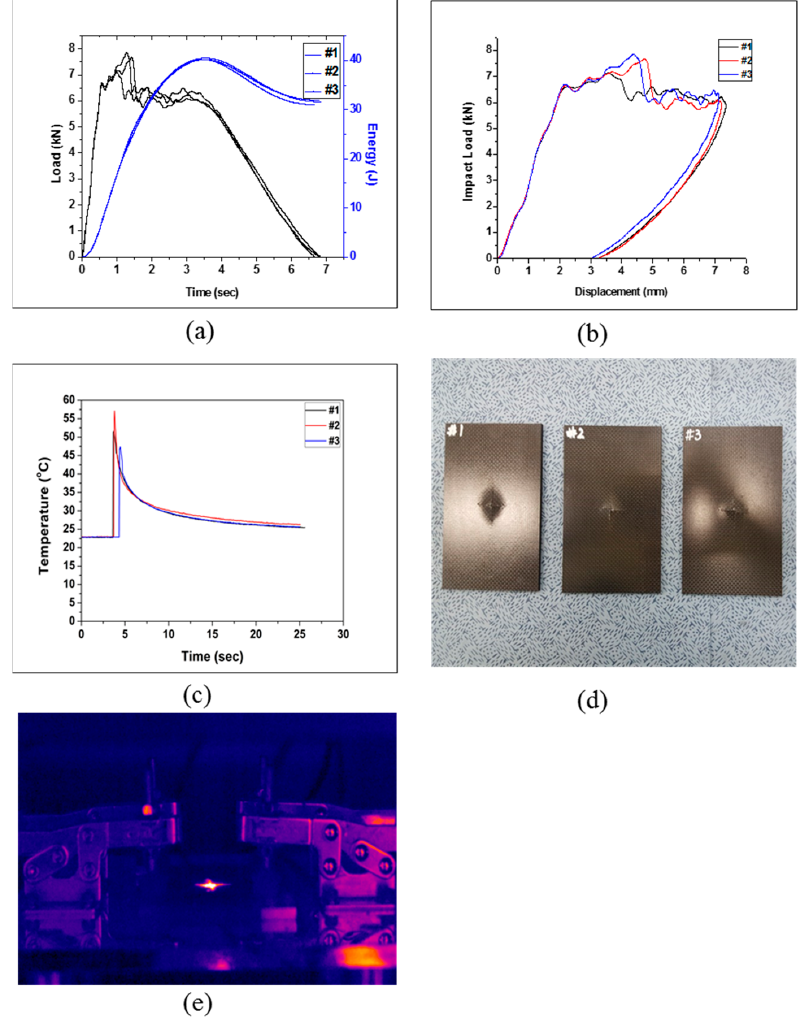
Figure 3. Impact test results of Type 1: ( a ) changes in load and energy with time, ( b ) impact load and displacement curve, ( c ) changes in temperature with time, ( d ) impact test of specimen Type 1, and ( e ) infrared (IR) image of the impact test (Type 1).